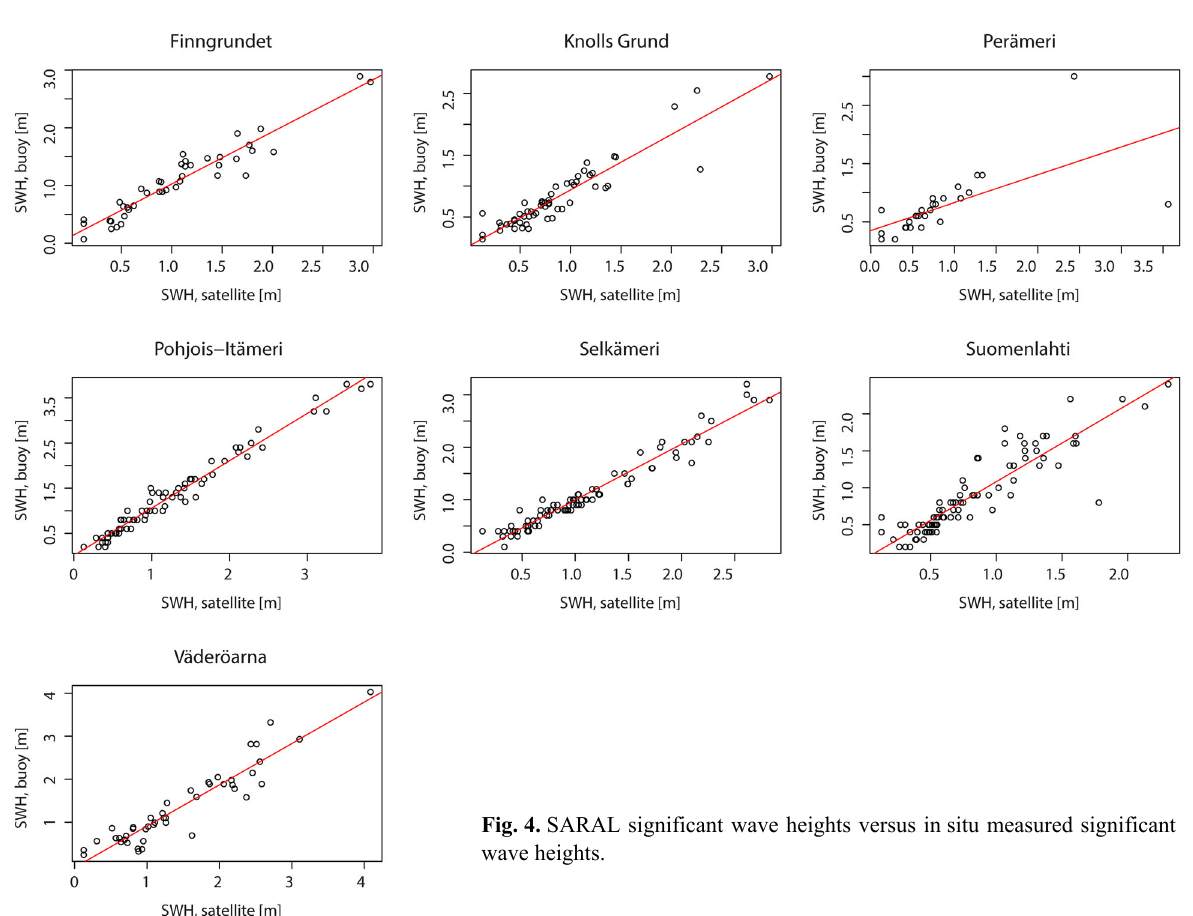
Fig. 4. SARAL significant wave heights versus in situ measured significant wave heights.